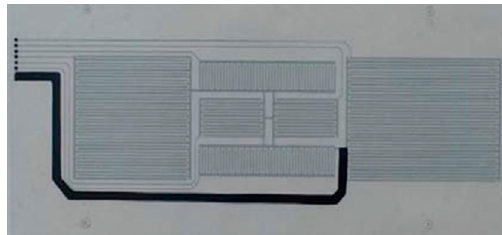
Figure 3. A printed sensor array with 6 sensors. PEDOT:PSS-IDEs on diaper